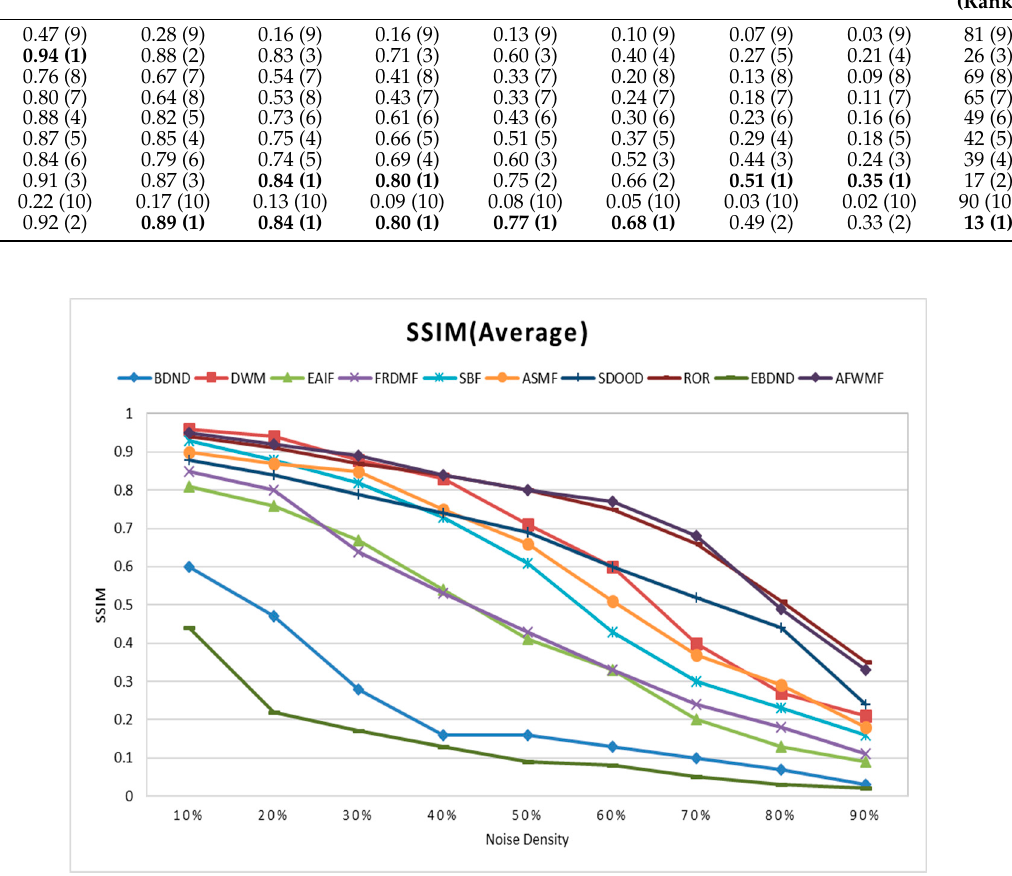
Table 17. The SSIM average value for the five experimental images at different noise densities from the 10 filter models. Model\Ratio